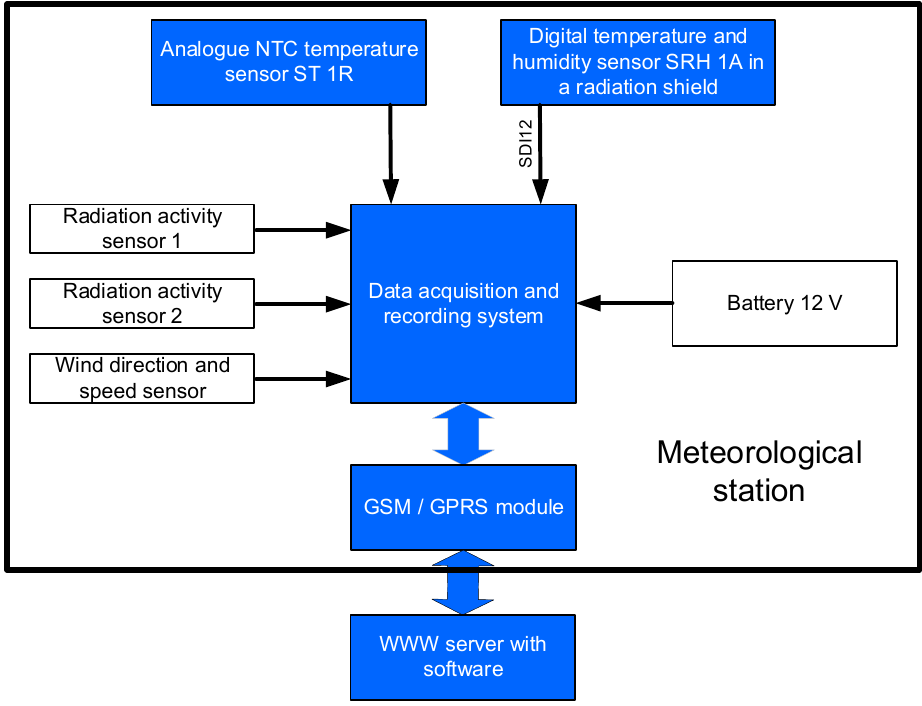
Figure 12. Block diagram of a meteorological station.